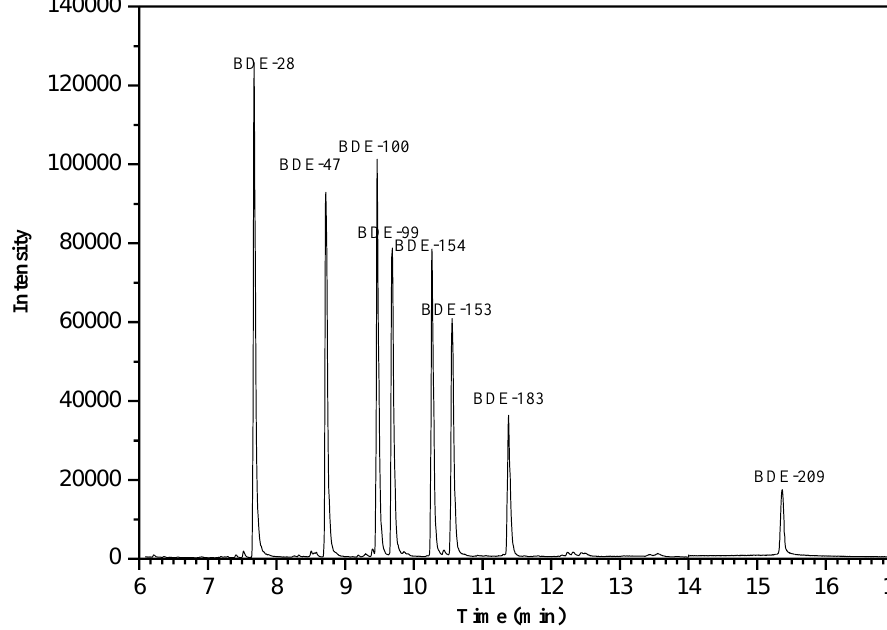
Figure 1. GC-NCI-MS chromatogram of eight PBDEs detected with a spike of 0.05 μg L − 1 .